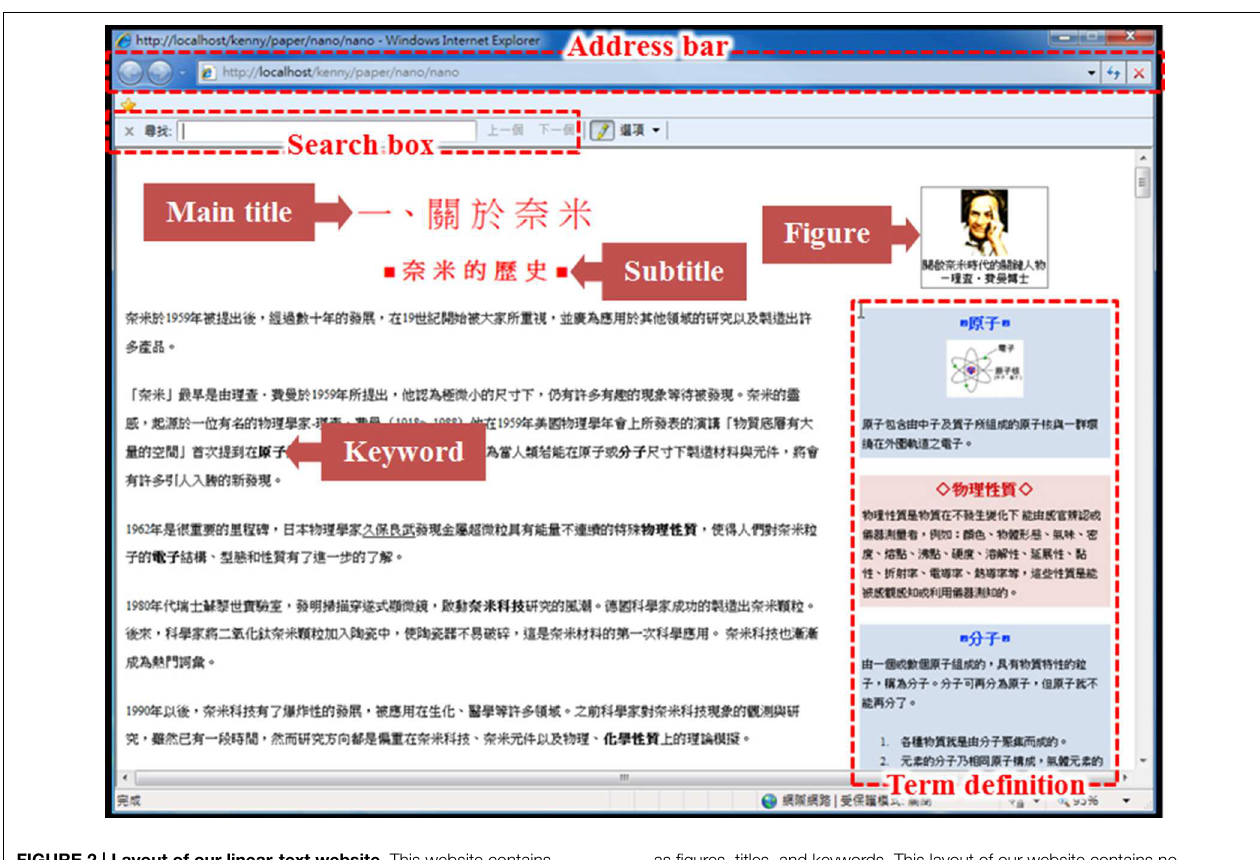
FIGURE 2 | Layout of our linear-text website. This website contains different functionalities, such as a search box. Within the figure, we have highlighted all of the various areas of interest used in our data analysis, such